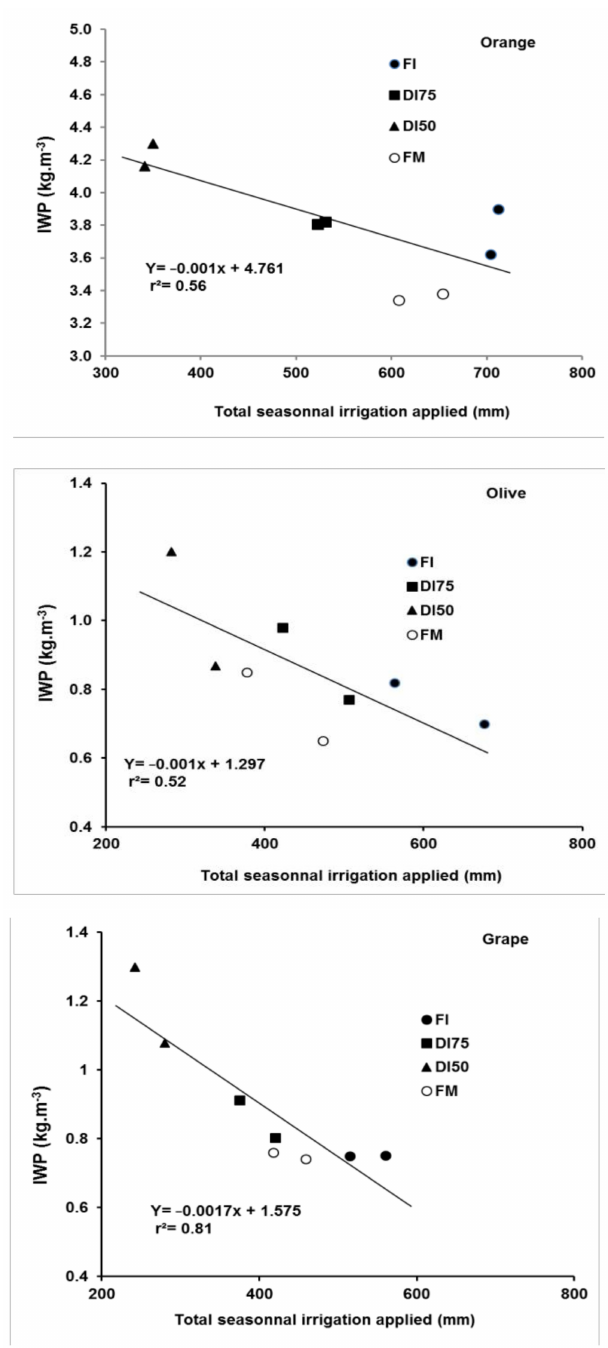
Figure 6. Irrigation water productivity (IWP, kg/m 3 ) of orange, table olive, and grapevine as related to water supply by irrigation under the applied irrigation strategies in 2013 and 2014. Full irrigation supplying 100% ETc (FI), deficit irrigation supplying 75% ETc (DI75) and 50% ETc (DI50),